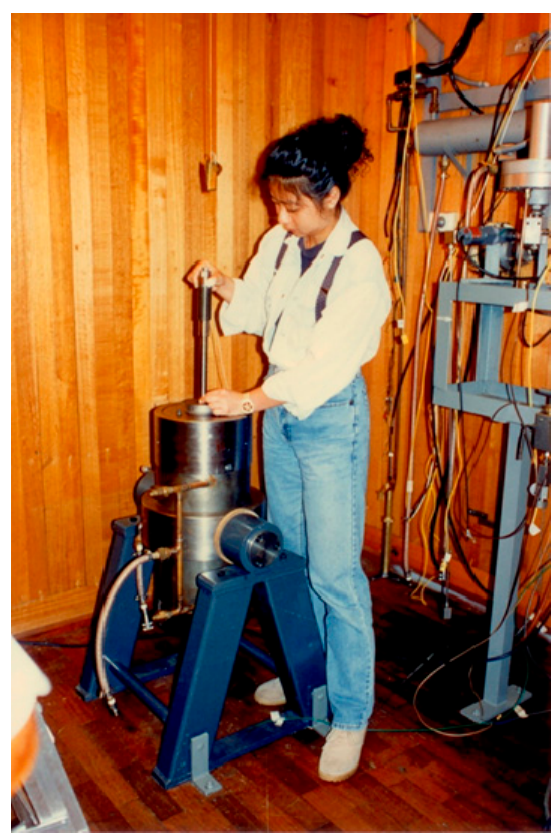
Figure 4. Jennifer Kung with high-temperature, ultrasonic apparatus in laboratory of Ian Jackson at the RSES at the ANU. Circa 2011.